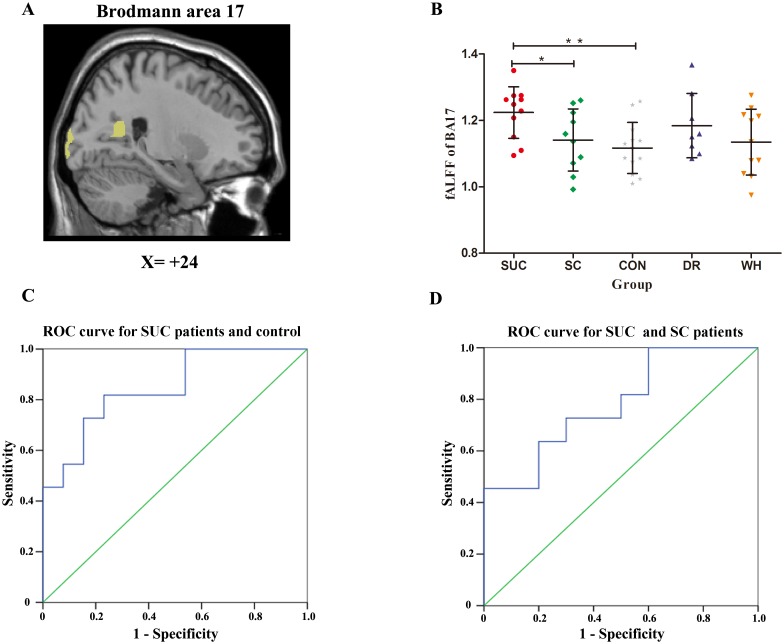
The fALFF values of BA17 and ROC curves.
A: BA17 mask. B: A scatter plot showing fALFF values within BA17 mask in the SUC, SC, DR, WH patients and healthy controls. The error bar represents the standard deviation. * P = 0.01, ** P = 0.026. C: An ROC curve for the SUC patients and healthy controls. The cut-off point of the fALFF value for this curve was 1.15. Using this cut-off point, 9 out of 11 SUC patients and 10 out of 13 healthy controls were correctly identified, with a sensitivity of 81.8% and a specificity of 76.9%. D: An ROC curve for the SUC and SC patients with a fALFF cut-off point of 1.20. Using this cut-off point, the fALFF of BA17 could classify 8 out of 11 SUC patients and 7 out of 10 SC patients, yielding a sensitivity of 72.7% and a specificity of 70.0%.